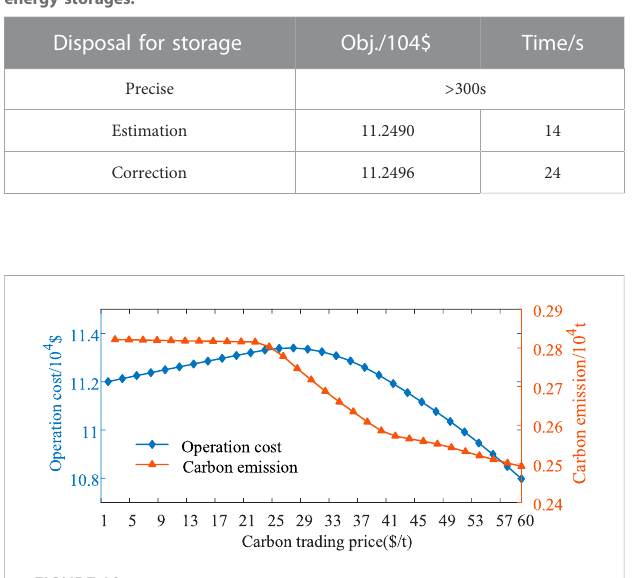
FIGURE 10 Variation trend in operation cost and carbon emissions relative to the carbon trading price.